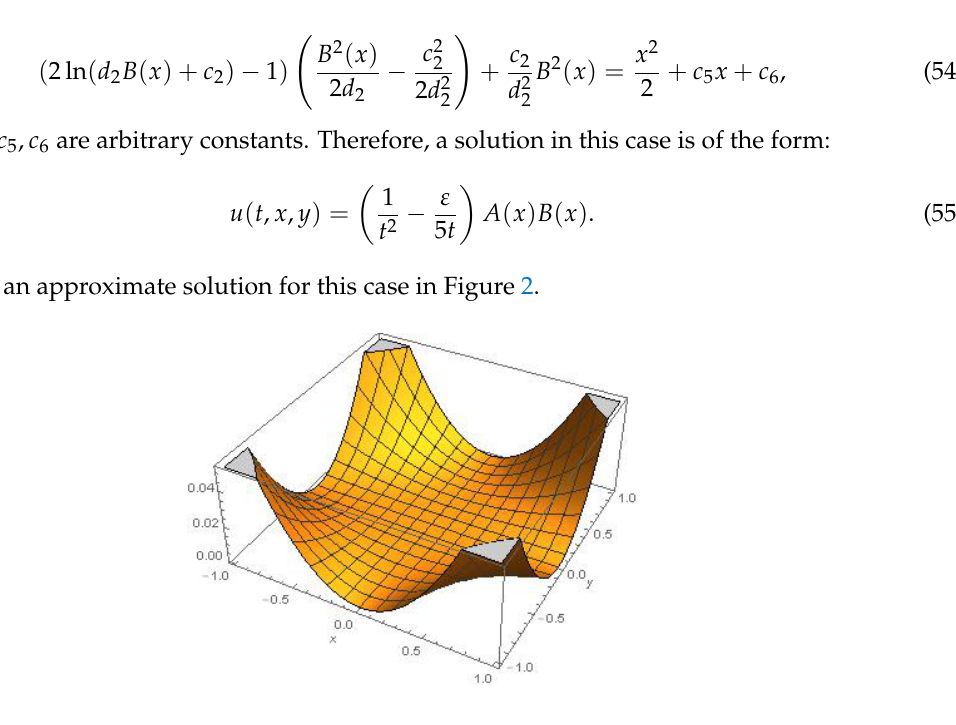
Figure 1. CaseI: approximate invariant solution of Equation (28) for t = π , − 1 ≤ x ≤ 1, − 1 ≤ y ≤ 1, ε =